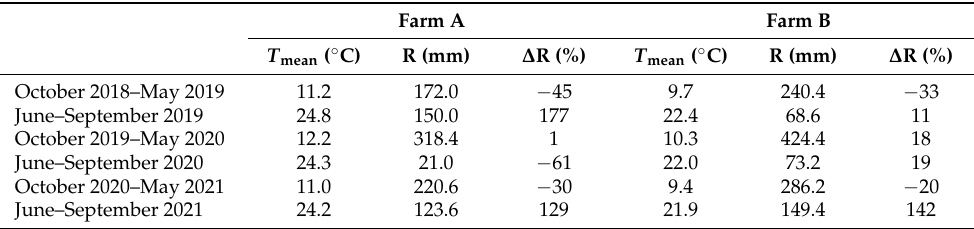
Table 1. Mean temperature ( T mean ) and cumulative rainfall (R) on the two experimental farms (La Poveda, farm A; El Socorro, farm B) during the study period, grouped in two intervals: the summer season (June to September) and the rest of the year (October to May). The percentage variation of accumulated precipitation ( ∆ R) in each time interval with respect to the average precipitation value (data for the period 2001–2021) for the same interval is also indicated.